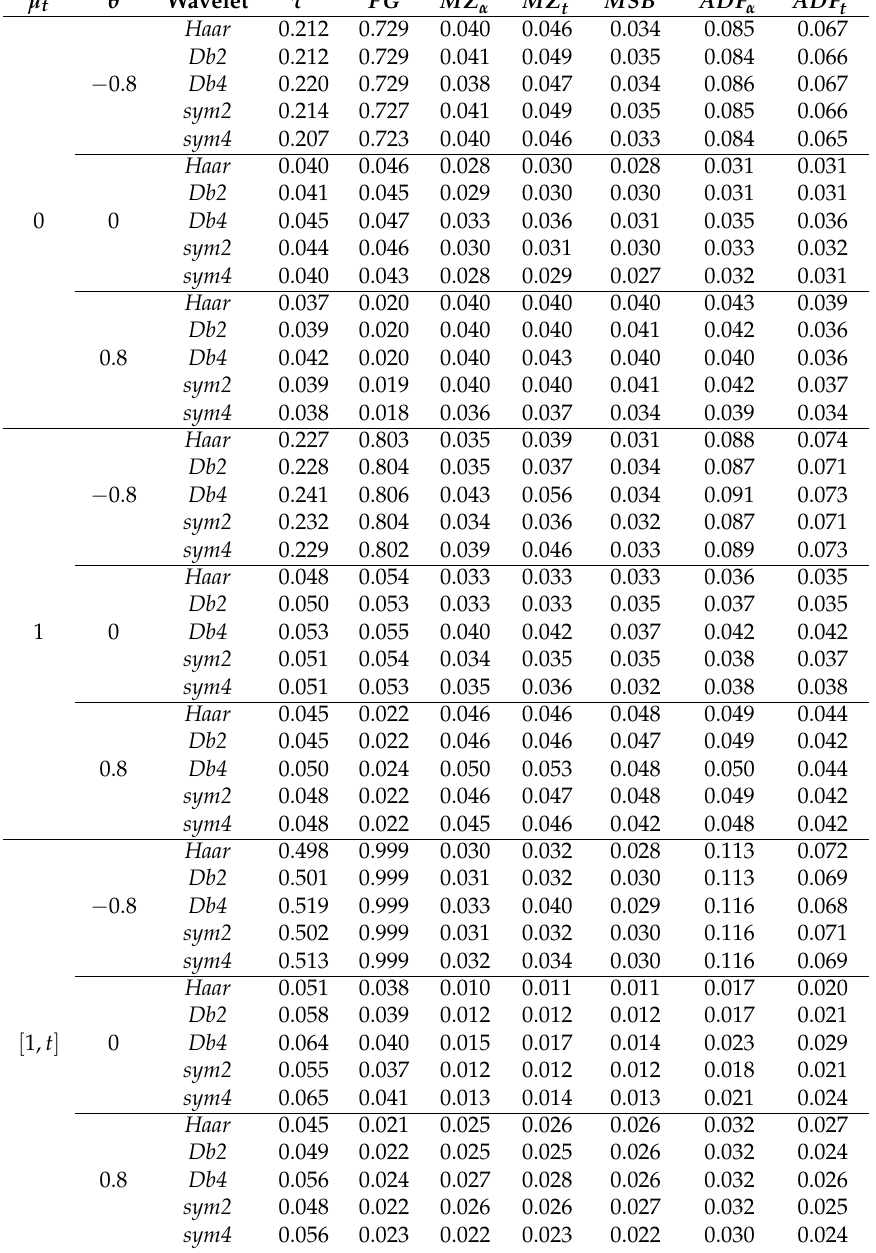
Table 2. The empirical size of wavelet based tests with sample size =